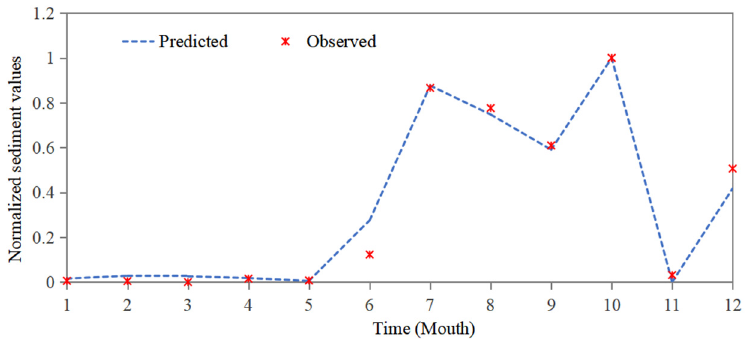
Figure 11. Observed and predicted values.